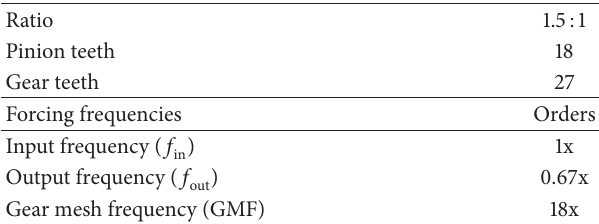
Table 1: Specifications of the test’s rig